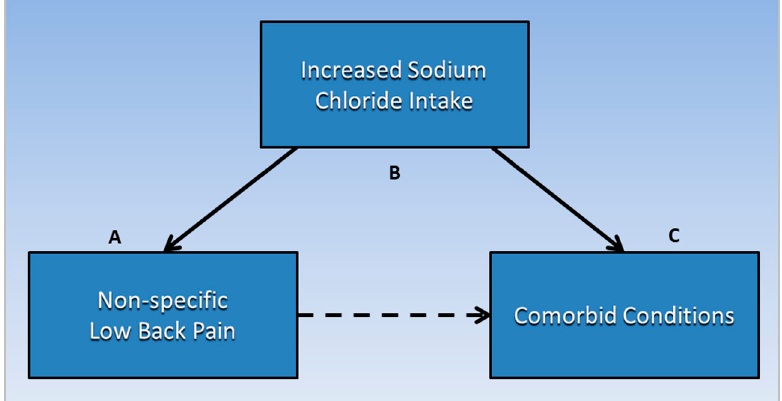
Figure 3. Non-specific low back pain ( A ) is transitively linked to comorbid conditions ( C ) through the common mediating factor of increased sodium chloride intake ( B ). Future studies should investigate prevalence of posterior lumbar subcutaneous edema in conditions comorbid with non-specific low back pain.